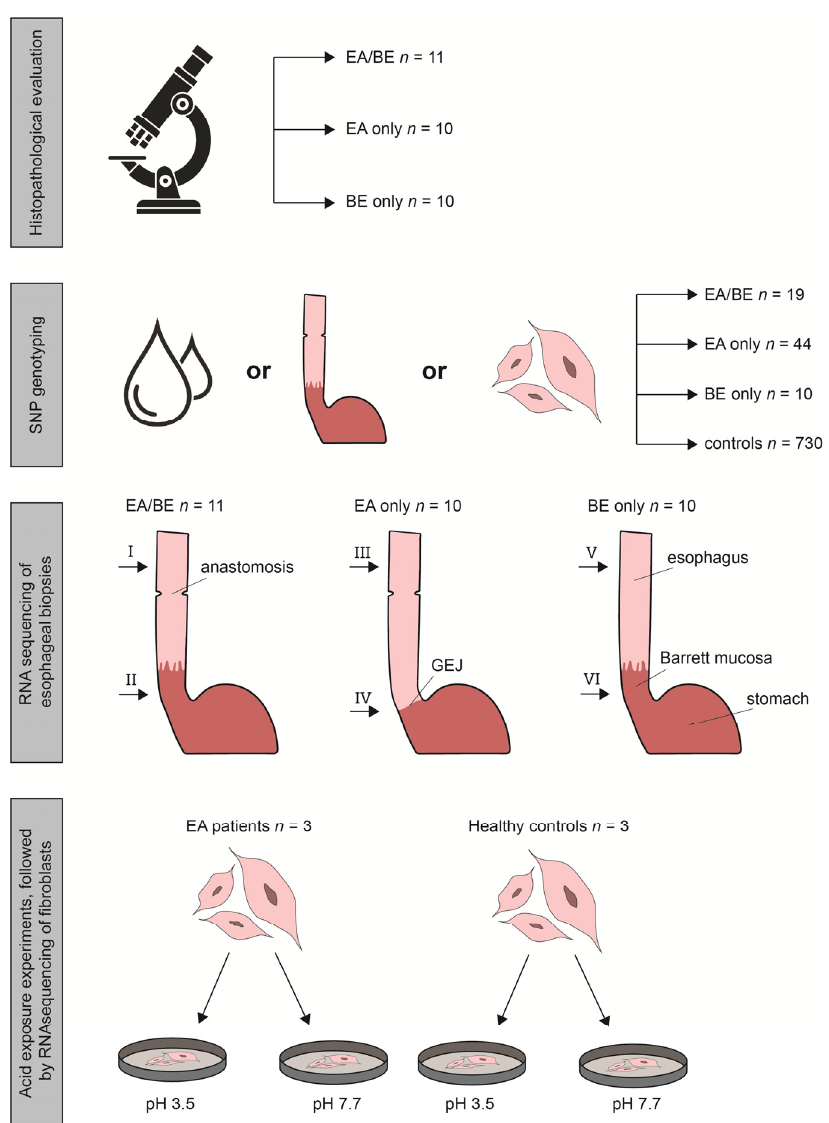
Figure 1. Schematic overview of the study set-up and number of patients included in each part. We compared three groups of patients: patients with esophageal atresia (EA) who have developed Barrett’s esophagus (BE, EA/BE), patients with EA without BE (EA-only), and patients with BE without EA in history (BE-only). BE-only patients were matched for age and gender with EA/BE patients. Roman numerals I to VI indicate the subgroups, based on the location of the biopsies. GEJ = gastroesophageal